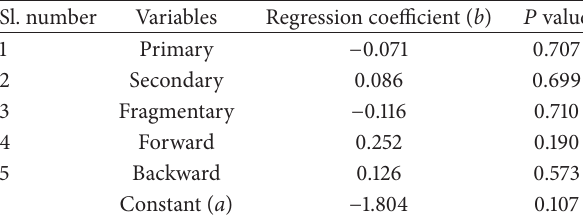
Table 9: Regression coefficient of all dimensions and directions. Sl. number